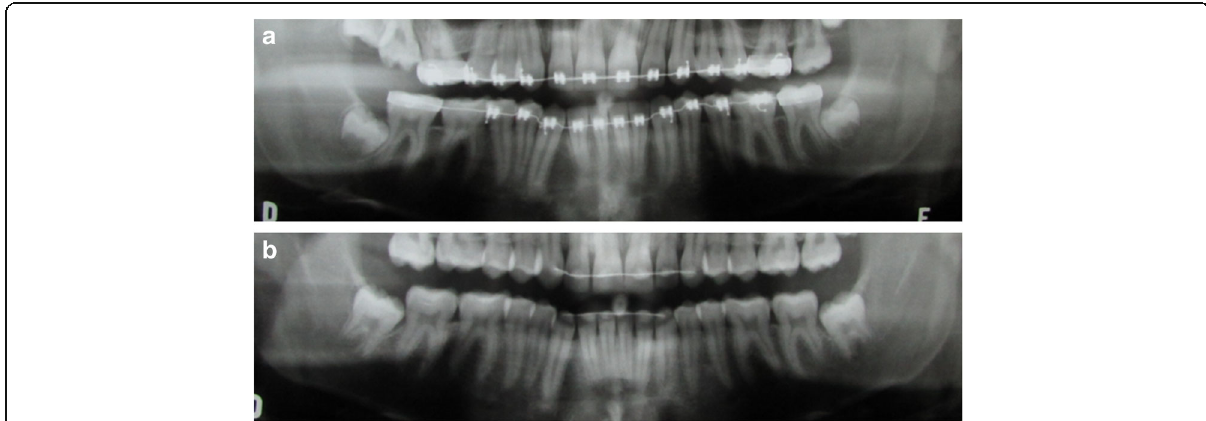
Fig. 1 Panoramic radiograph at the end of orthodontic treatment (XR1) of patient # 21 (positive control group) at 15 years and 7 months of age